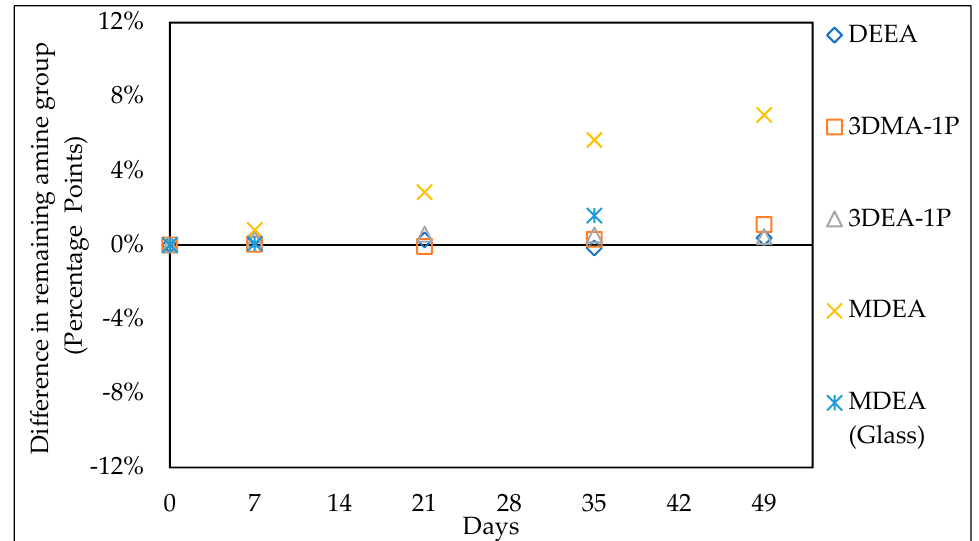
Figure 8. Difference between the remaining amine group (percentage points) of aqueous amine solution vs. the amine–TEG blends; unloaded amine wt.% = 30; CO 2 loading ≈ 0.1.